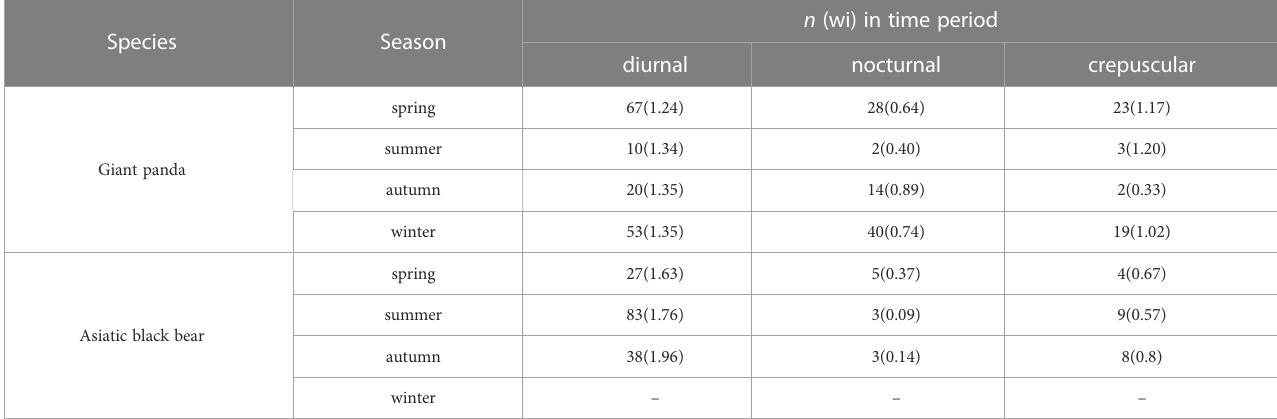
TABLE 3 The number of independent detections n (selection ratio: wi) of diurnal, nocturnal, and crepuscular time periods for giant pandas and Asiatic black bears in the Changqing National Nature Reserve, China from April 2014 to October 2017.